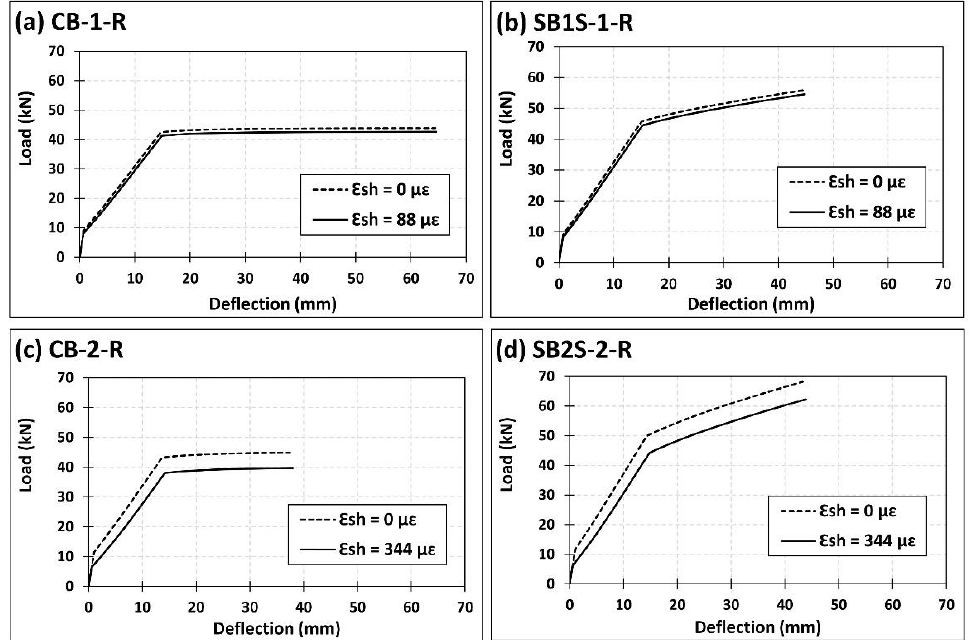
Figure 8. Analytical predictions of load–deflection curves with and without accounting for the shrinkage effect for specimens ( a ) CB-1-R; ( b ) SB1S-1-R; ( c ) CB-2-R; and ( d ) SB2S-2-R.